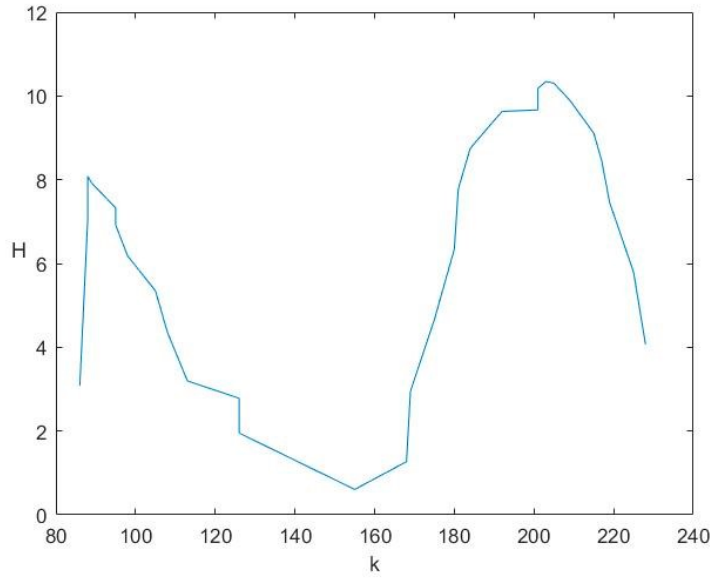
Figure 4. Variation curve of H value of image #253036 from BSDS with gray value.